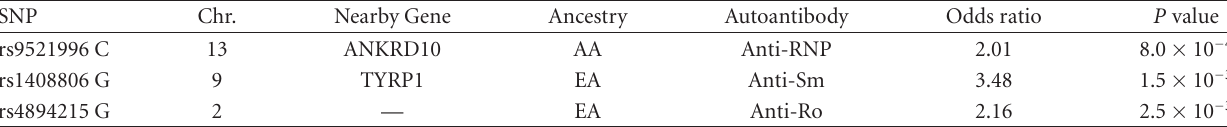
Table 1: Summary of SNPs associated with autoantibody traits.